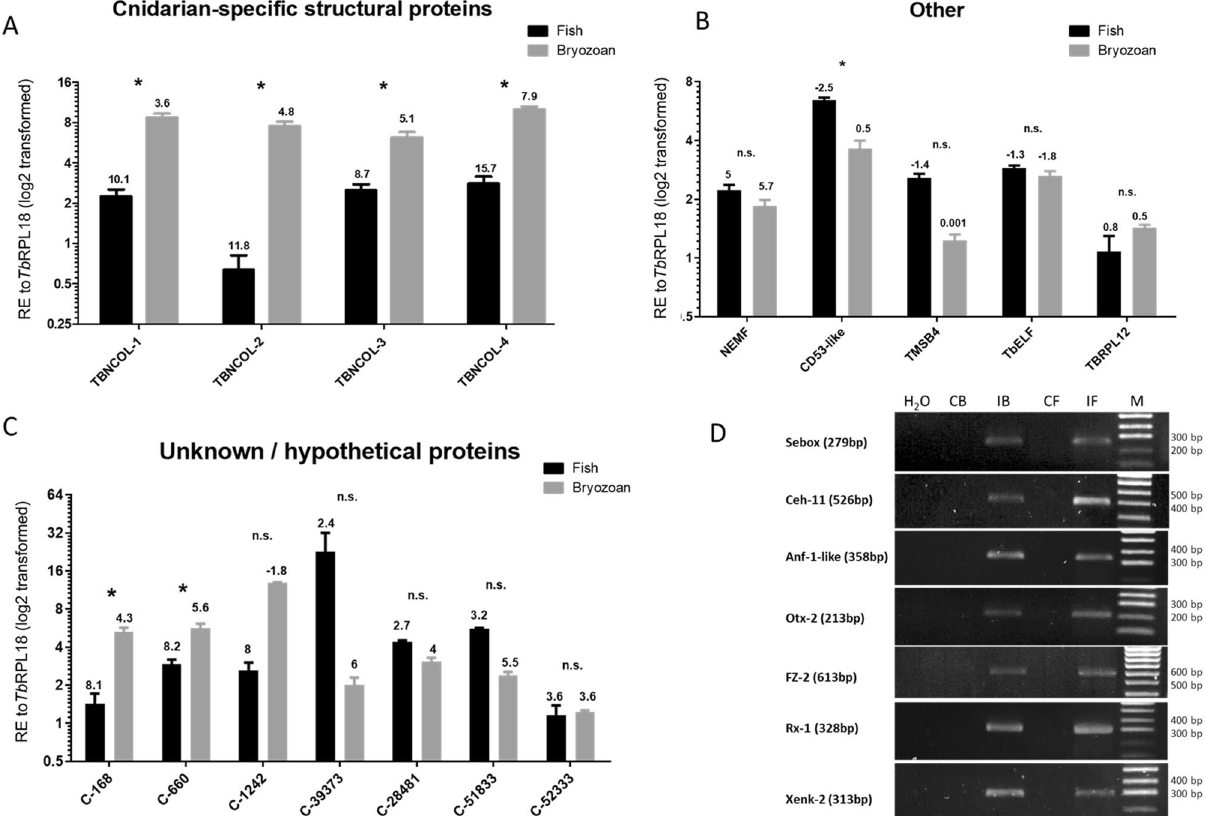
Figure 8. Average relative gene expression in infected bryozoan and infected fish kidney tissues of; ( A ) Cnidarian-specific structural proteins, ( B ) reference and immune-related proteins, ( C ) unknown proteins. All gene values were normalized to Tb RPL18. Δ Cq values, stated above each bar, represent the expression level of genes of interest relative to Tb RPL18 in each infected host with values > 1 indicating lower expression and values < 1 indicating higher expression relative to Tb RPL18. * P < 0.05; *** P < 0.001. Black bars = infected fish, grey bars = infected bryozoan. ( D ) PCR profile showing the presence of Sebox, Ceh-11, Anf-1-like, Otx-2, FZ-2, Rx-1 and Xenk-2 in negative control (H 2 0), uninfected bryozoan and fish kidney controls respectively (CB and CF) and T. bryosalmonae -infected bryozoan and fish genomic DNA respectively (IB and IF). M = Molecular weight marker. Full-length gel images are presented in Supplementary Fig. S3. Gene abbreviations: putative group 1 minicollagen-1/2/3/4 (TBNCOL-1/2/3/4), nuclear export mediator factor (NEMF), Thymosin beta 4-like protein (TMSB4), Tetraspanin CD53-like (CD53-like), T. bryosalmonae elongation factor alpha ( Tb ELFa) and T. bryosalmonae ribosomal protein L12 ( Tb RPL12), Unknown proteins C-168, C-660, C-1242, C39373, C-28481, C-51833 and